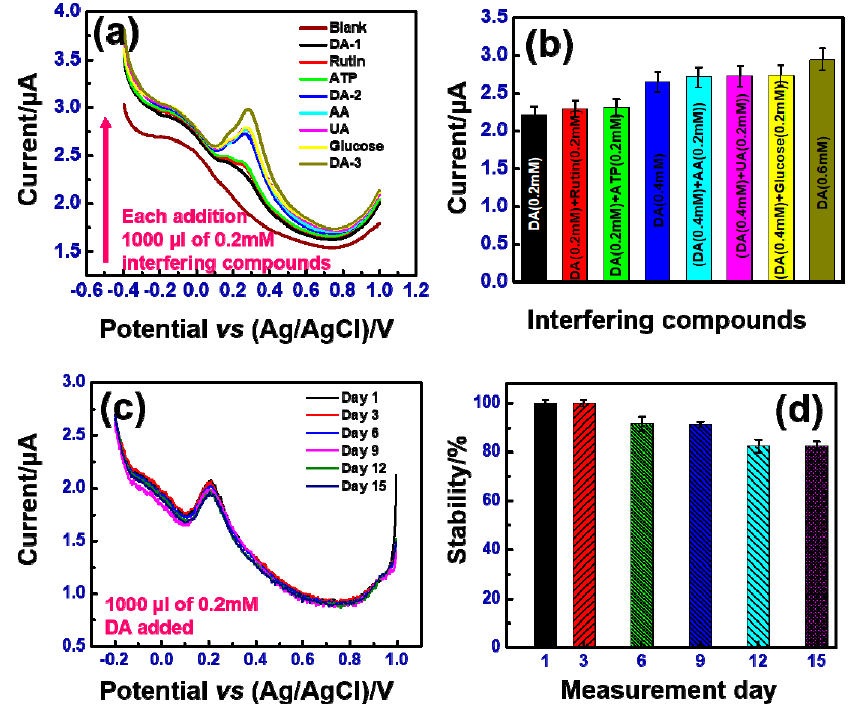
Figure 8. ( a ) Interference analysis of the CeO 2 / siloxene-modified electrode in the presence of other interfering compounds; ( b ) Current change response to the interfering compounds; ( c , d ) Stability of the CeO 2 / siloxene-modified electrode in the presence of 1000 µ L of 0.2 mM of DA containing 0.1 M PBS solution.